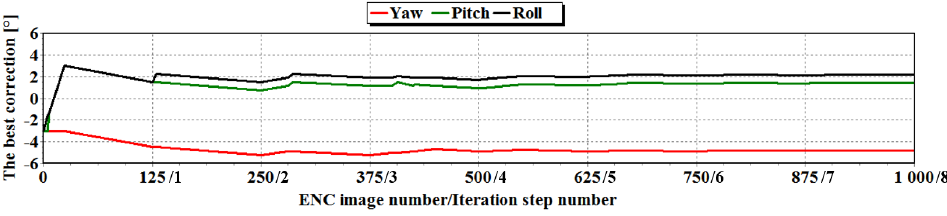
Figure 16. Graphs of the values of corrections of spatial orientation angles ( ∆ ψ cor , ∆ θ cor , ∆ φ cor ) during the iteration process for photograph No. 1.